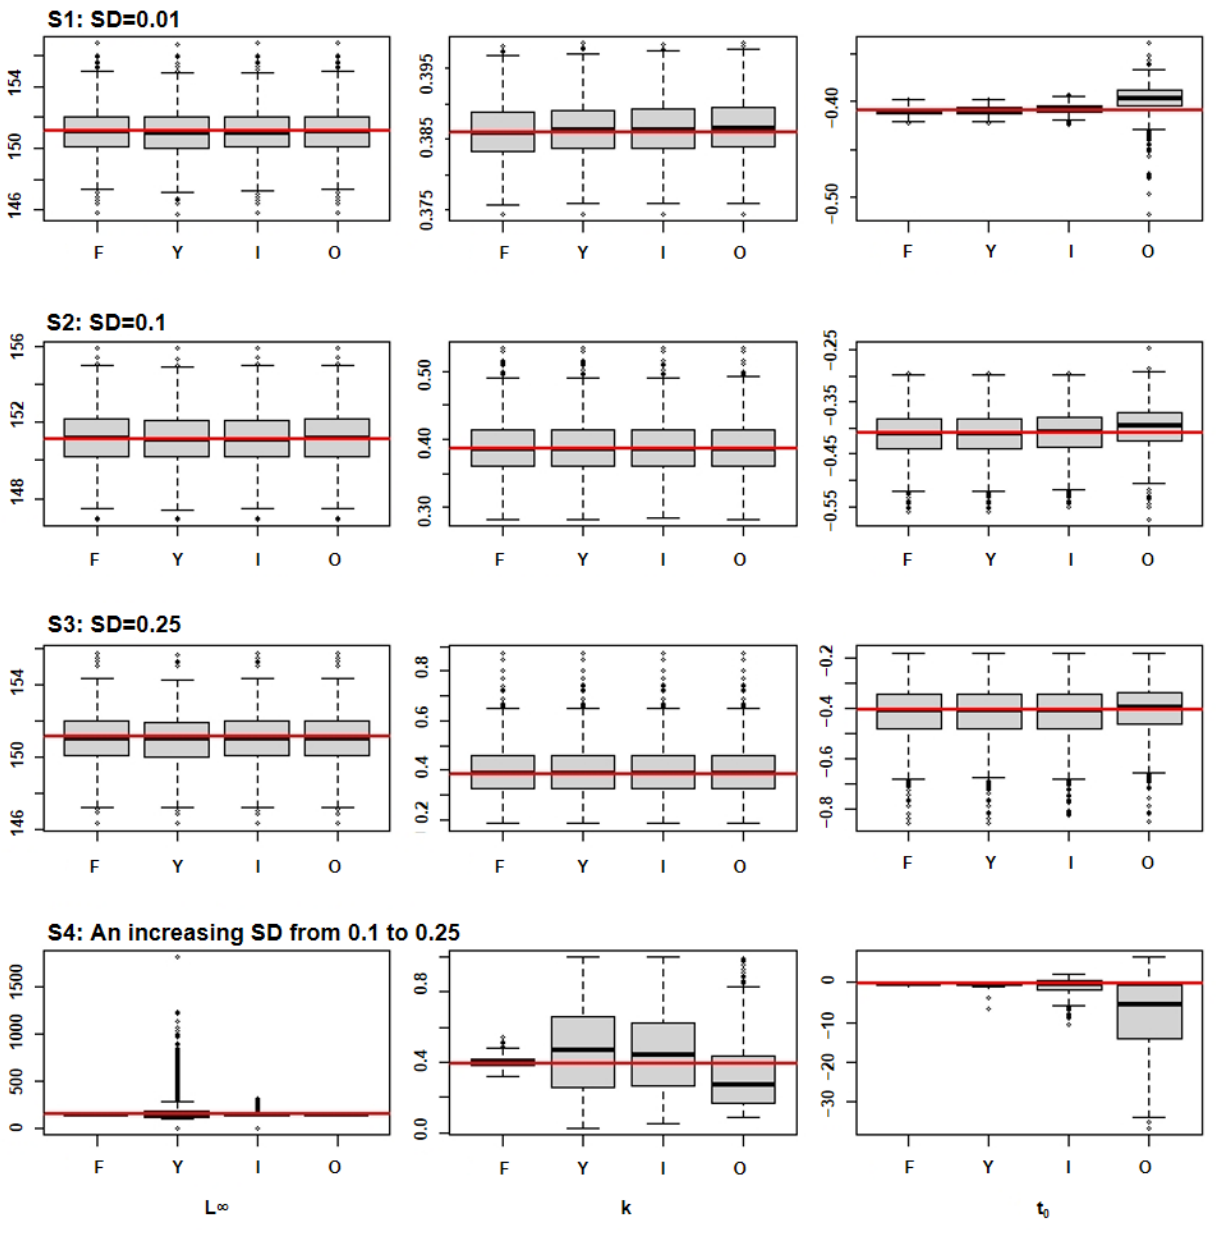
Figure 3. Distributions of estimated growth parameters of simulated bigeye tuna (the red line is the initial parameter; L ∞ , k and t 0 are three parameters in the Von Bertalanffy growth model).